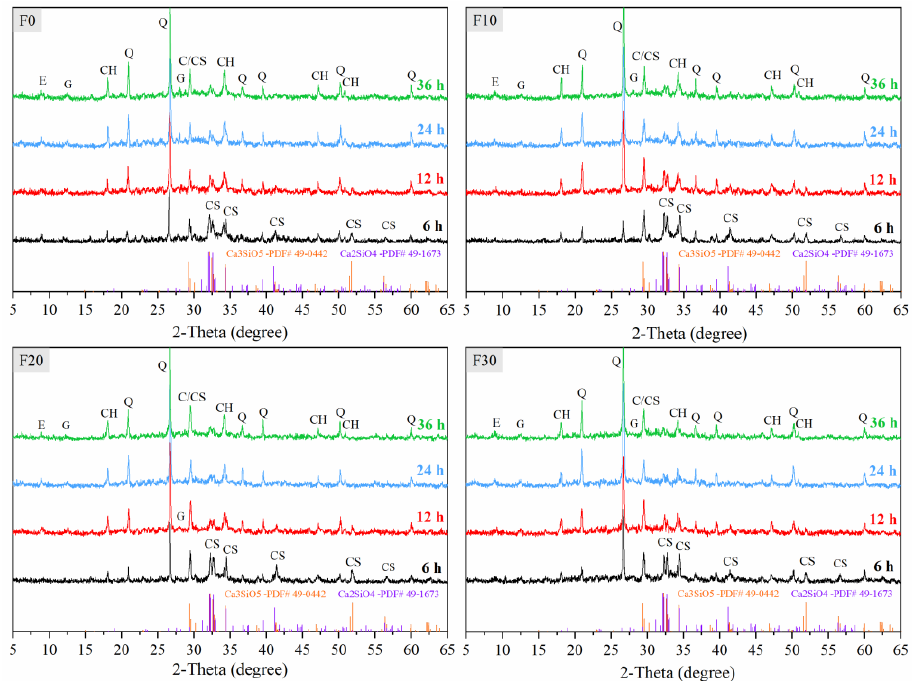
Figure 9. XRD at constant temperature under steam curing. E – Ettringite; CH – Portlandite; Q – Quartz; C – Calcite; CS – C 3 S/C 2 S; G – Gismondine.